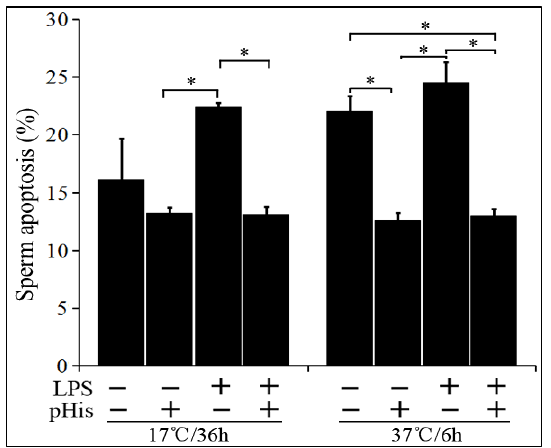
Figure 5. pHis inhibited LPS-induced sperm apoptosis in both liquid-stored (17 °C) and incubated boar semen (37 °C).* indicates a significant difference ( p < 0.05).